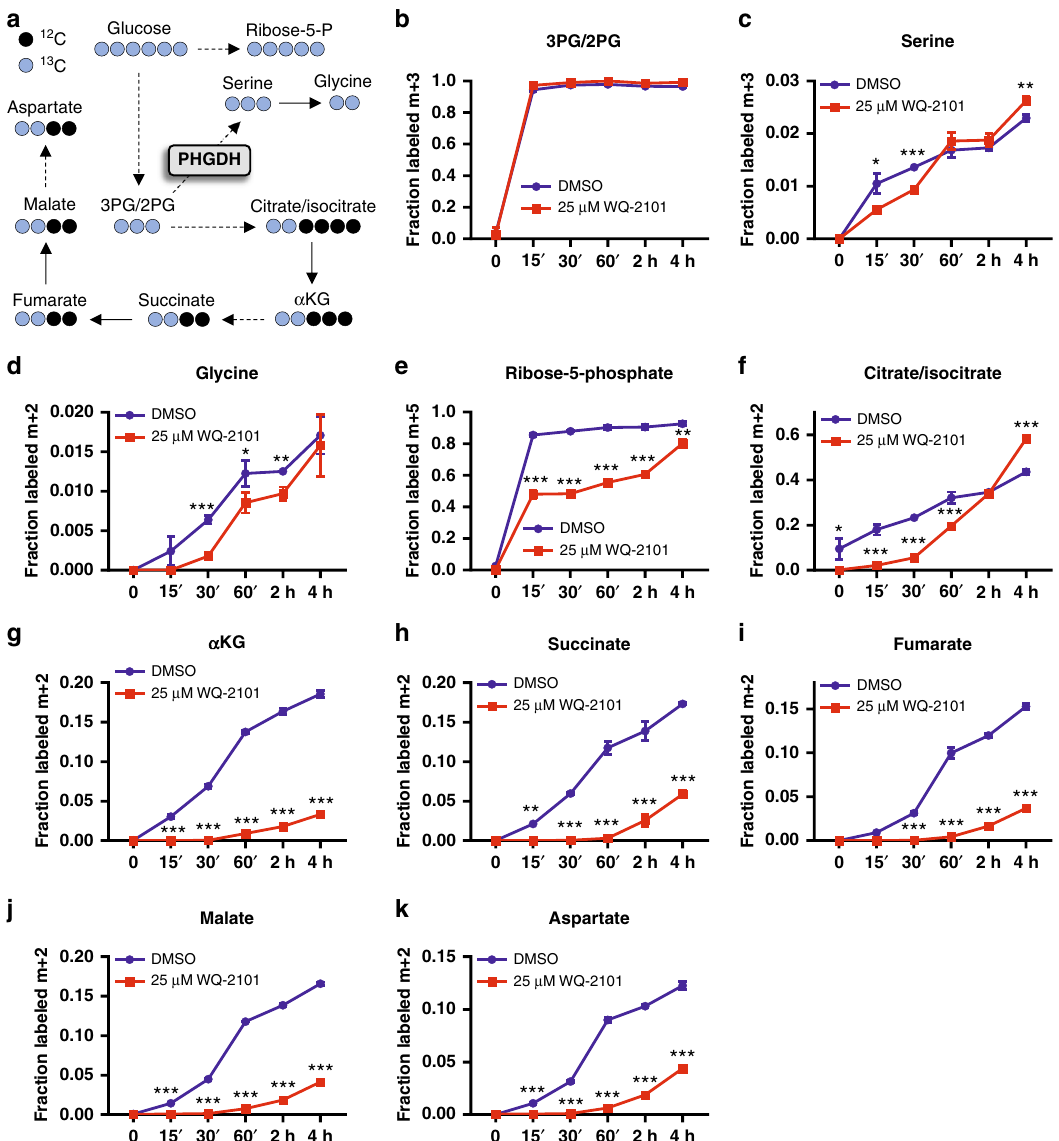
Fig. 5 Kinetic pro fi ling con fi rms reduced fl ux into the TCA cycle and PPP upon PHGDH inhibition. a Schematic of [U- 13 C] glucose labeling of serine, glycine, and central carbon metabolites. b Fraction of the m + 3 isotopomer of 3PG/2PG (3-phosphoglycerate/2-phosphoglycerate) labeled in the presence (red) or absence (blue) of 25 μ M WQ-2101. 3PG/2PG (3-phosphoglycerate/2-phosphoglycerate). Data are the mean of three biological replicates, and error bars represent s.e.m. c Fraction of the m + 3 isotopomer of serine labeled in the presence (red) or absence (blue) of 25 μ M WQ-2101. Data are the mean of three biological replicates, and error bars represent s.e.m. P < 0.05 [*], P < 0.01 [**], P < 0.005 [***], Student ’ s t -test. d Fraction of the m + 2 isotopomer of glycine labeled in the presence (red) or absence (blue) of 25 μ M WQ-2101. Data are the mean of three biological replicates, and error bars represent s.e.m. P < 0.05 [*], P < 0.01 [**], P < 0.005 [***], Student ’ s t -test. e Fraction of the m + 5 isotopomer of ribose-5-phosphate labeled in the presence (red) or absence (blue) of 25 μ M WQ-2101. Data are the mean of three biological replicates, and error bars represent s.e.m. P < 0.01 [**], P < 0.005 [***], Student ’ s t -test. f – k Fraction of the m + 2 isotopomers of citrate/isocitrate, α KG ( α -ketoglutarate), succinate, fumarate, malate, and aspartate labeled in the presence (red) or absence (blue) of 25 μ M WQ-2101. Data are the mean of three biological replicates, and error bars represent s.e.m. P < 0.05 [*], P < 0.01 [**], P < 0.005 [***], Student ’ s t -test. In all experiments, cells were pre-treated with 25 μ M WQ-2101 for 24h followed by introduction of [U- 13 C] glucose- containing medium including inhibitor for the indicated